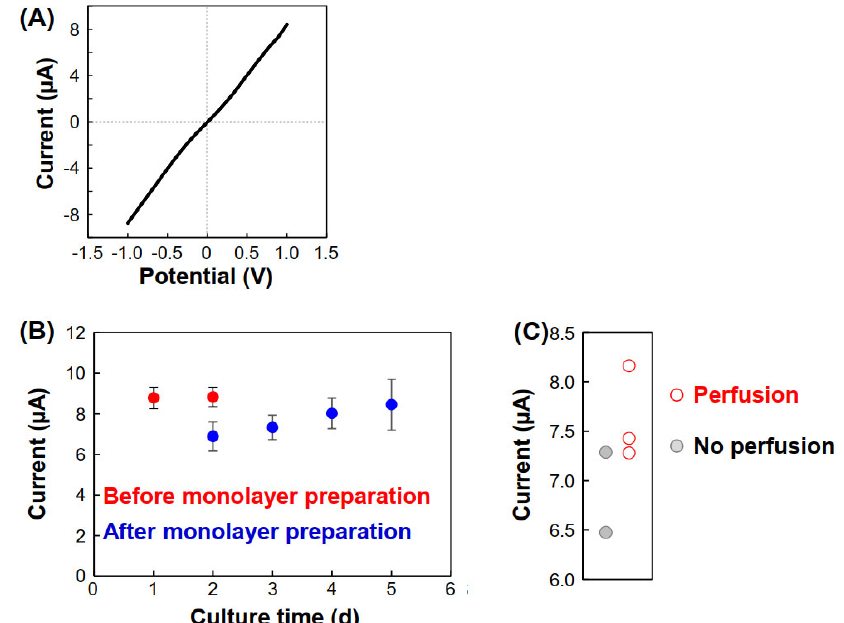
Figure 6. Ion currents at 1.0 V using the culture medium in Chs. 2 and 4 during the assay. ( A ) Current vs. potential after 1 d. The data is shown from -1.0 to 1.0 V. ( B ) Ion current vs. culture time. The values were obtained from the currents at 1.0 V of the I-V curves. N = 4–5. The error bars indicate SDs. ( C ) Ion currents and perfusability after 3 d. The current values of two out of the three perfusion samples were higher than those of the samples with no perfusion.